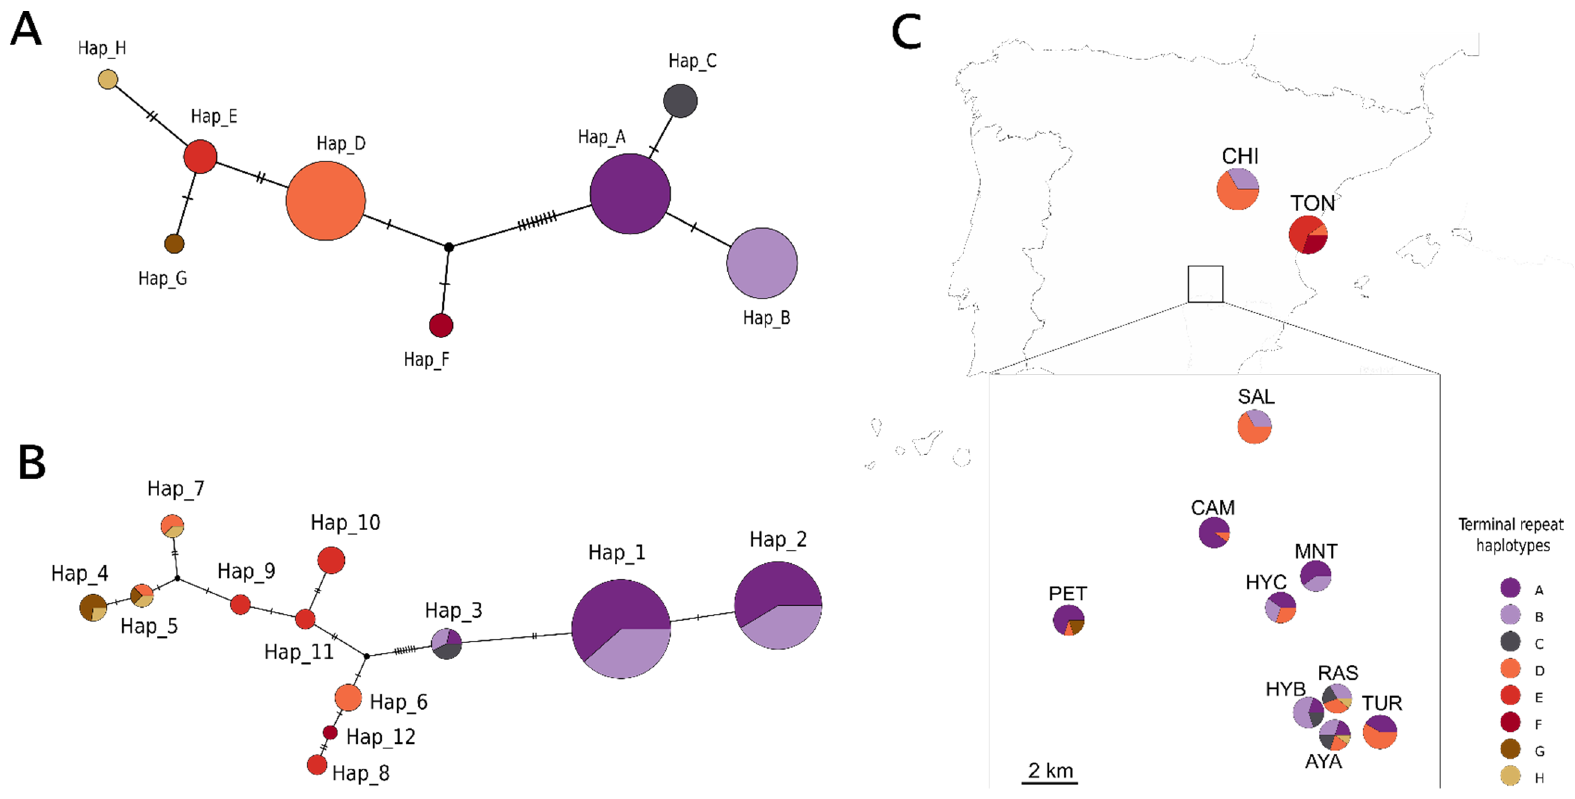
Figure 3. Haplotype network for terminal ( A ) and full ( B ) repeats of mmr-b . The colour codes signify different haplotypes of terminal repeat. In the case of a network for full repeats, the colour fractions represent the proportion of terminal repeats appearing in the sequence with the particular full repeat. ( C ) Relative frequency of each terminal repeat in the studied populations with their geographical location on a map of Spain .